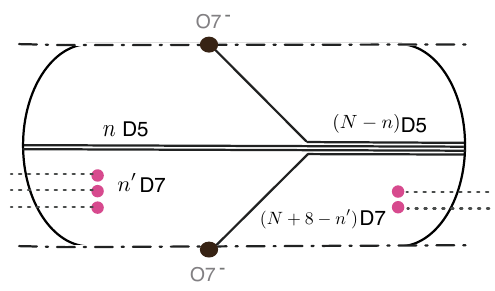
Figure 8 . A T-dual description of (cid:12)gure 7.